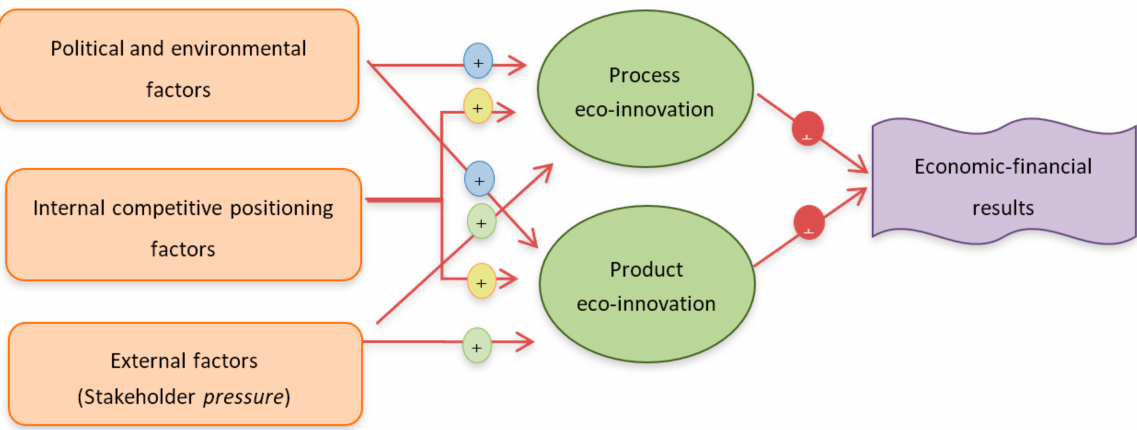
Figure 2. Proposed model.